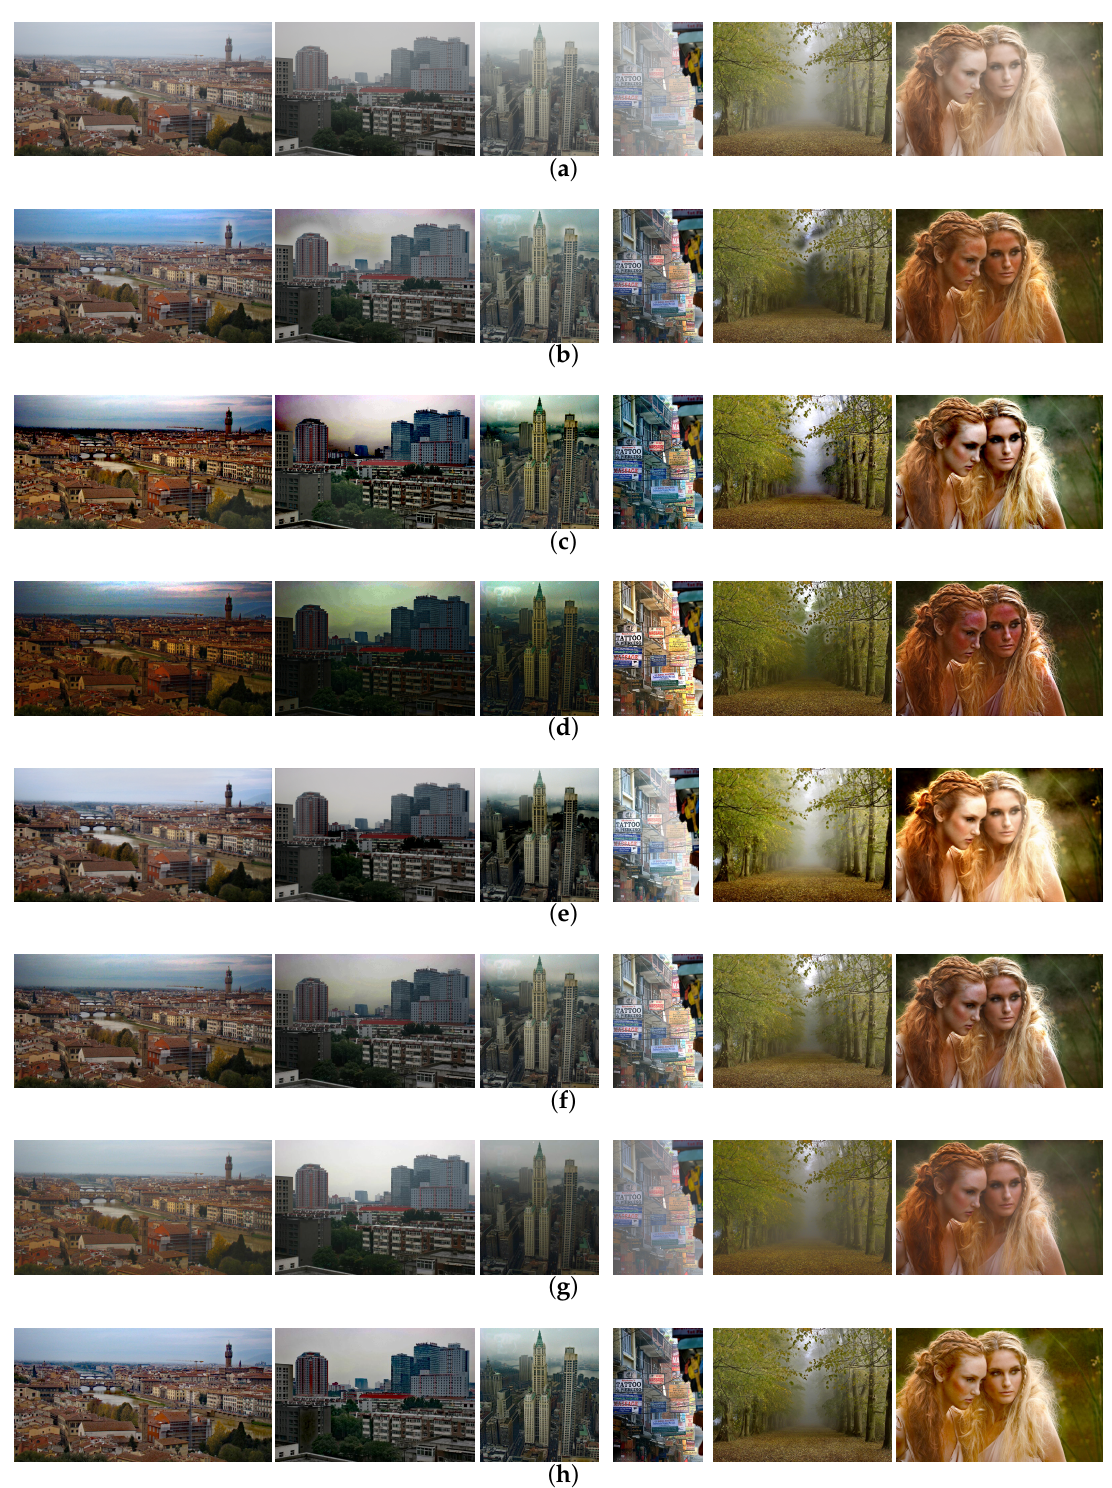
Figure 5. Dehazing results.(recommended viewing color pictures on display). ( a ) Hazy images; ( b ) results of DCP; ( c ) Berman et al.’s results; ( d ) Bui et al.’s results; ( e ) results of DCPDN; ( f ) Zhu et al.’s results; ( g ) Golts et al.’s [18] results; ( h ) our